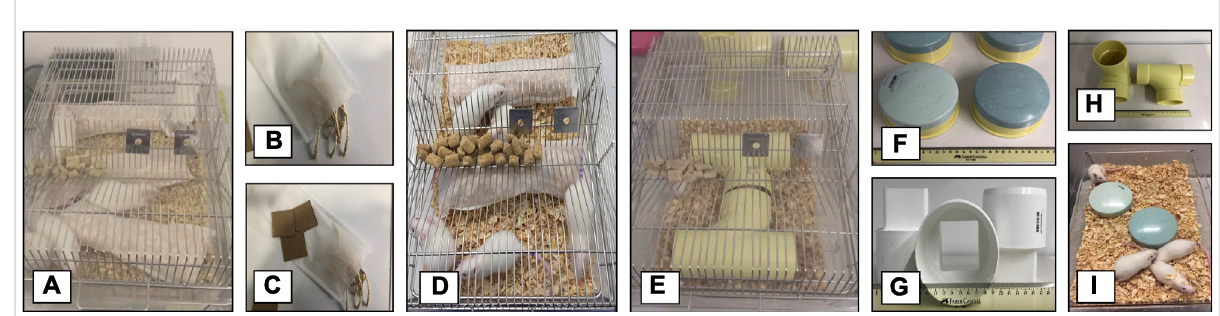
FIGURE 2 Environmental enrichment. (A,D) Foraging-environmental enrichment disposition at the home cage. (B,C) Material used for foraging- environmentalenrichment. (E,I) Physical-environmentalenrichmentdispositionatthehomecage. (F,G,H) Material usedfor physical-environmental